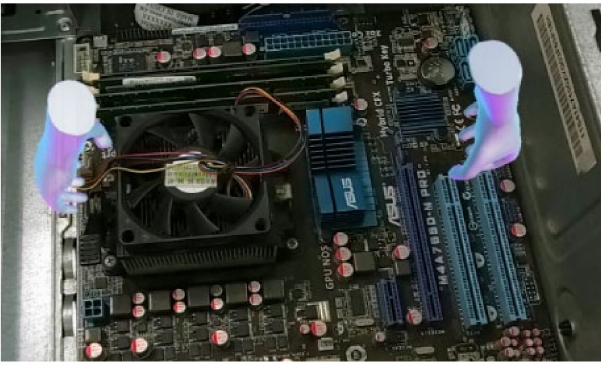
Figure 9. Virtual hands show how to grab the motherboard to move it